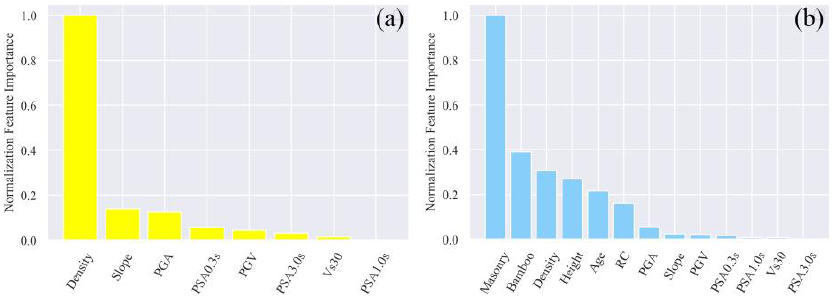
Figure 8. Feature importance of different feature combinations. Subplot ( a ) represents the EASY mode, and subplot ( b ) represents the HARD mode.